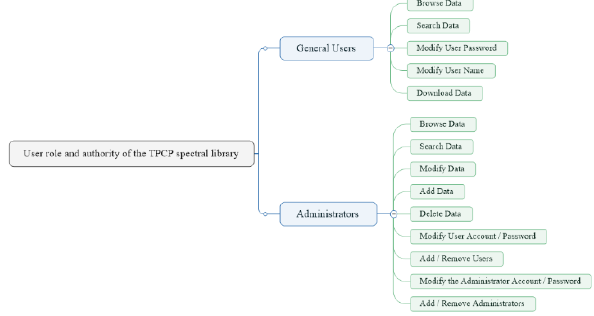
Figure 5. User role and